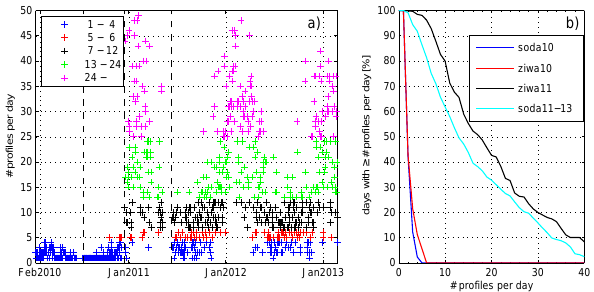
Fig. 1. Dual-polarisation receiver of MIAWARA-C after Decem- ber 2010. The signal is split by the orthomode transducer and anal- ysed using two separate receiver chains.